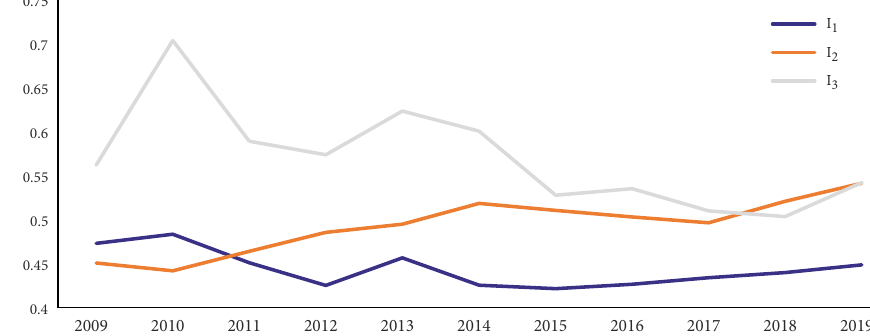
Figure 5. The average values of normalized indicators: environment, society, and economy by years